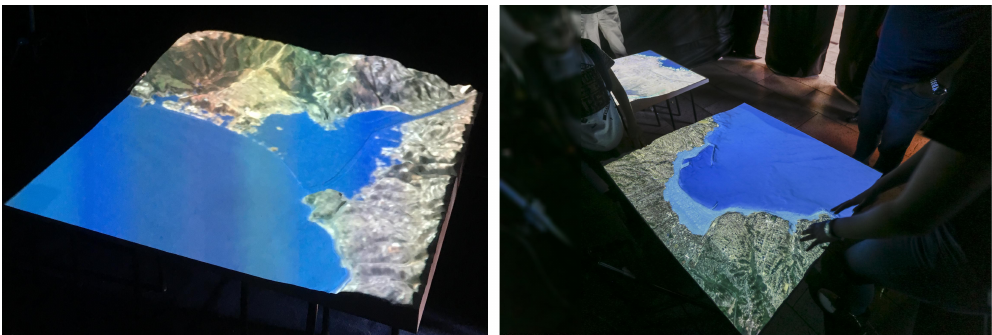
Figure 6. Projection mapping of tsunami inundation on scaled relief models (mock-ups) for Viña del Mar (left panel) and Valparaíso (right panel). Refer to videos 1 and 2 that can be accessed in Supplementary